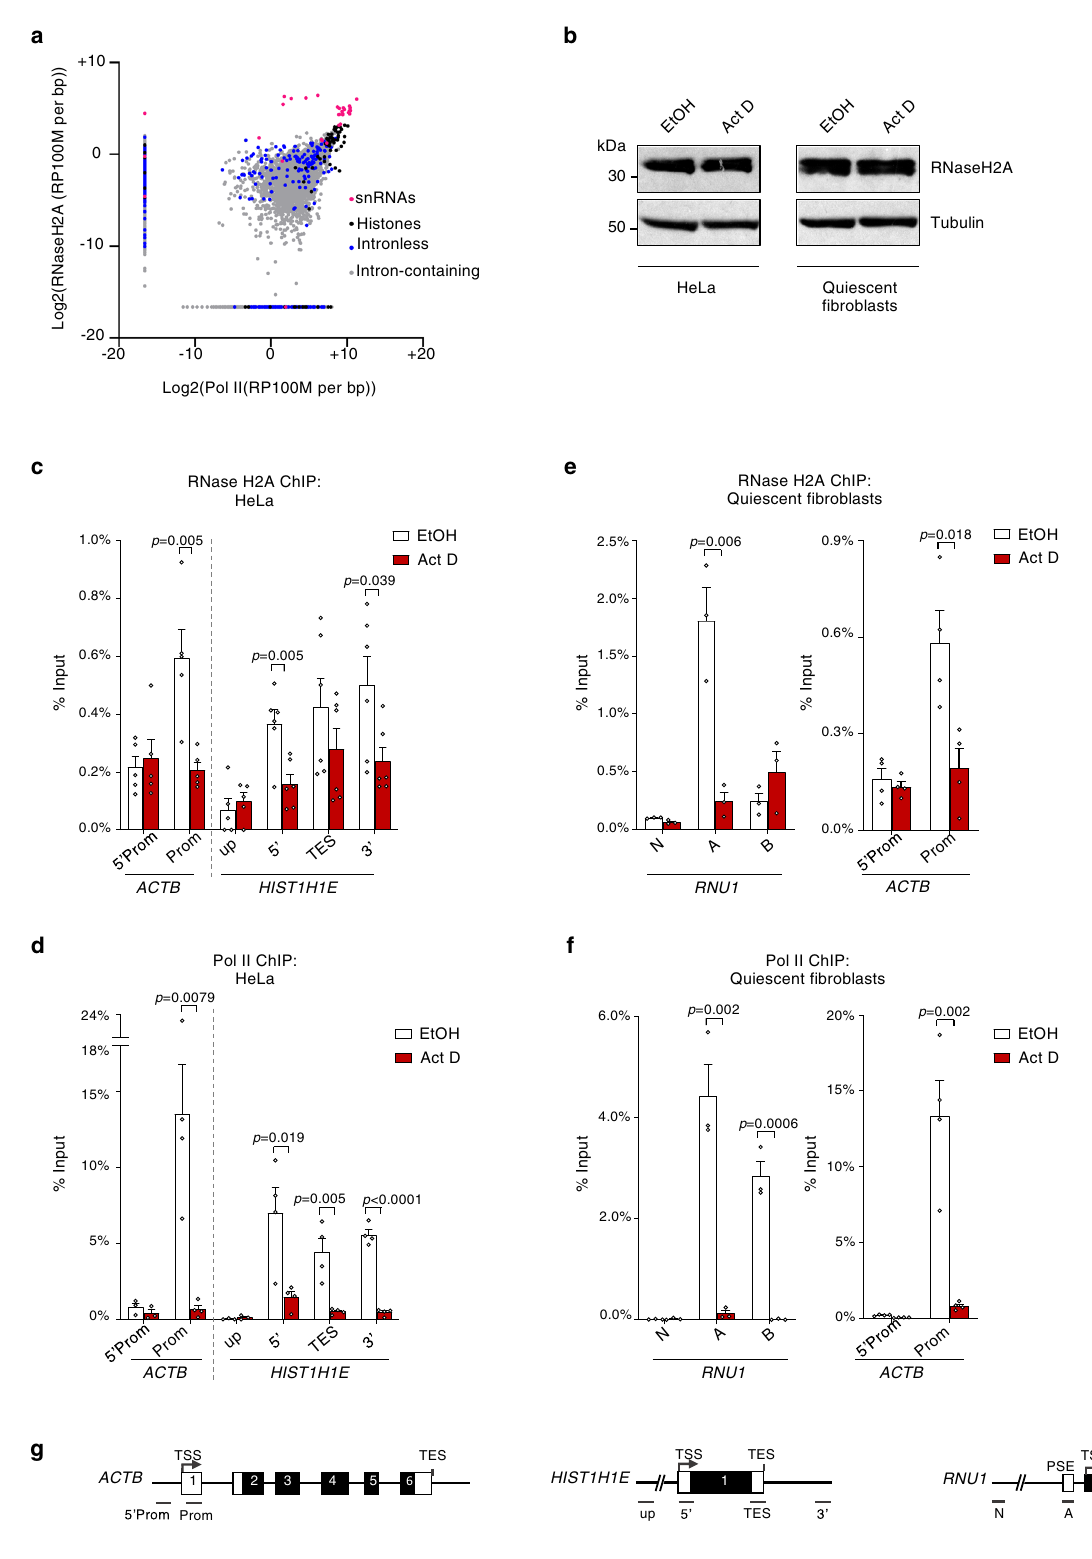
levels upon RNase H2 depletion (Fig. 4f right panel and Sup- plementary Fig. 5g). This suggests that despite RNase H2 binding to these genes, either its R-loop-resolving activity is not necessary or it can be compensated by other factors. Consistent with short genes being affected stronger by RNase H2 depletion, protein- coding genes positive for RNase H2A binding in ChIP-seq are signi fi cantly shorter compared to RNase H2A-negative genes NATURE COMMUNICATIONS| (2022) 13:2961